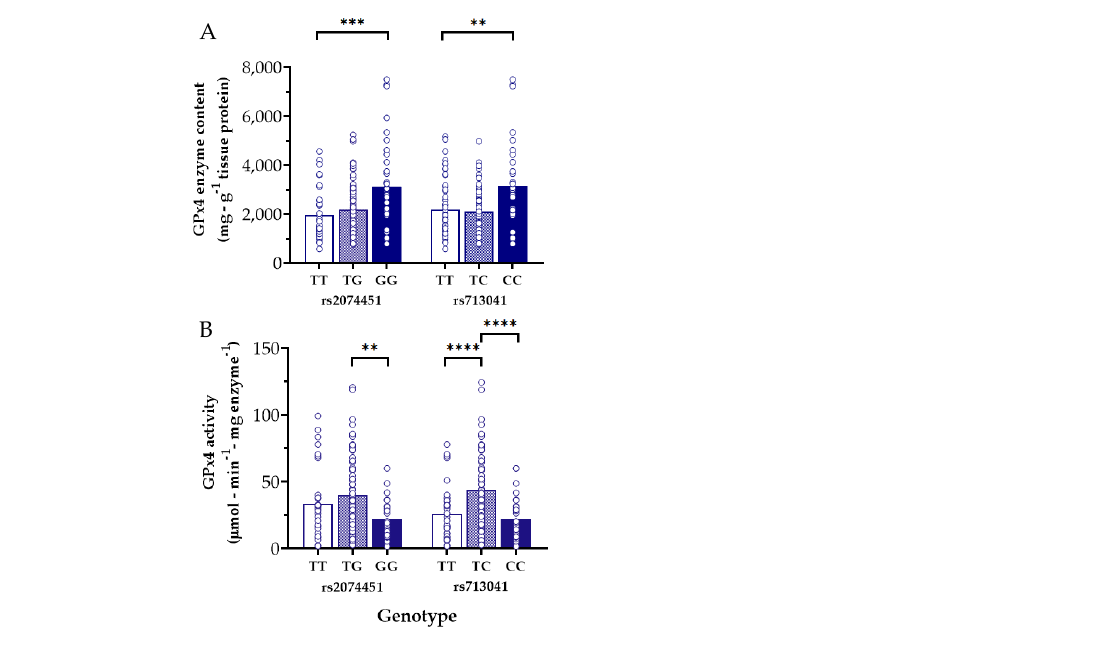
Figure 4. GPX4 variants associated with increased GPx4 enzyme content but decreased activity in human atrial myocardium. Two distinct polymorphisms associated with increased tissue levels of GPx4 protein ( A ) but decreased GPx4 activity ( B ) are shown in the panels above. Each open circle represents one patient, open bars = Homozygous for the Referent nucleotide, hatched bars = Heterozy- gous for the variant nucleotide (i.e., one allele), filled bars = Homozygous for the variant nucleotide. **** p < 0.0001, *** p < 0.001, ** p < 0.01 for main effect between genotypes